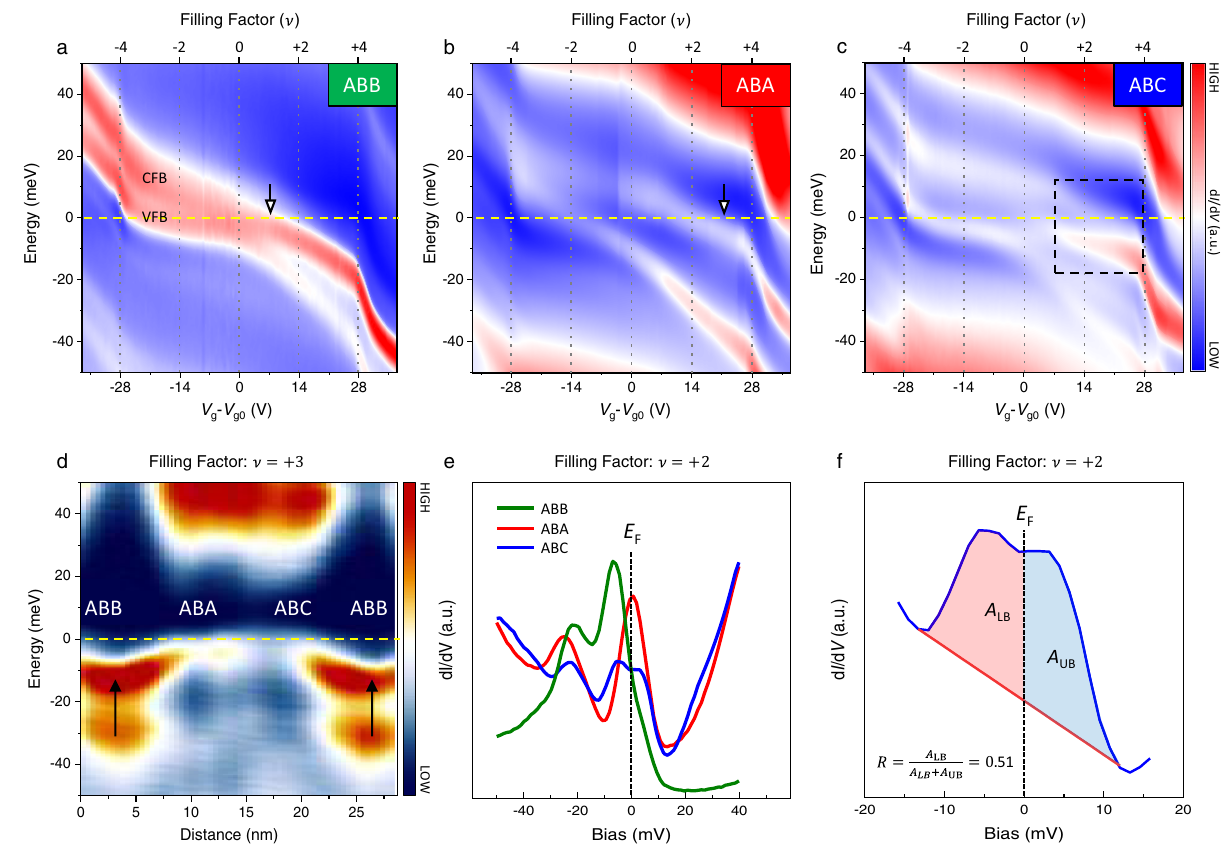
Fig. 2 Charge separation. a – c The color contours of the d I /d V evolution as a function of doping level ( V g ) and fi lling factor ( ν ) for ABB, ABA, and ABC, respectively ( V b = − 50 mV, I = 200 pA), here V g0 = 3 V is the gate voltage to make the system charge neutral. The fi lling factors ν that are deduced from the gate voltages. The yellow dashed lines in each panel indicate the Fermi level that we set as E F = 0 meV. VFB and CFB label the valence fl at band and conduction fl at band in ( a ). The black arrows in a ( b ) label the full fi ling at ν ¼ 1 ( ν ¼ 3). The dashed square in c highlights the correlation gap in the ABC region around Fermi level ( E F ). d Line pro fi le of d I /d V spectra shows the fl at-band bending at ν ¼ 3 along the dashed line in Fig. 1b. The arrows show the electron pools in the ABB region. Dash line labels the E F . e d I /d V spretra at ν ¼ 2 at the ABB, ABA, and ABC regions, wherein the fl at bands show different fi lling status. Dash line labels the E fi lling, R , of CFB from the d I /d V spectrum (blue curve) in e , where A LB ( A UB ) is the area F . f Extracting the local effective under the spectrum of CFB below (above) E F . By following this method discussed in the main text, the extracted R = 0.51, corresponding to the scenario of two electrons fi lling the CFB in the ABC. The dashed line indicates the E F , red line services as the base line for removing the spectrum